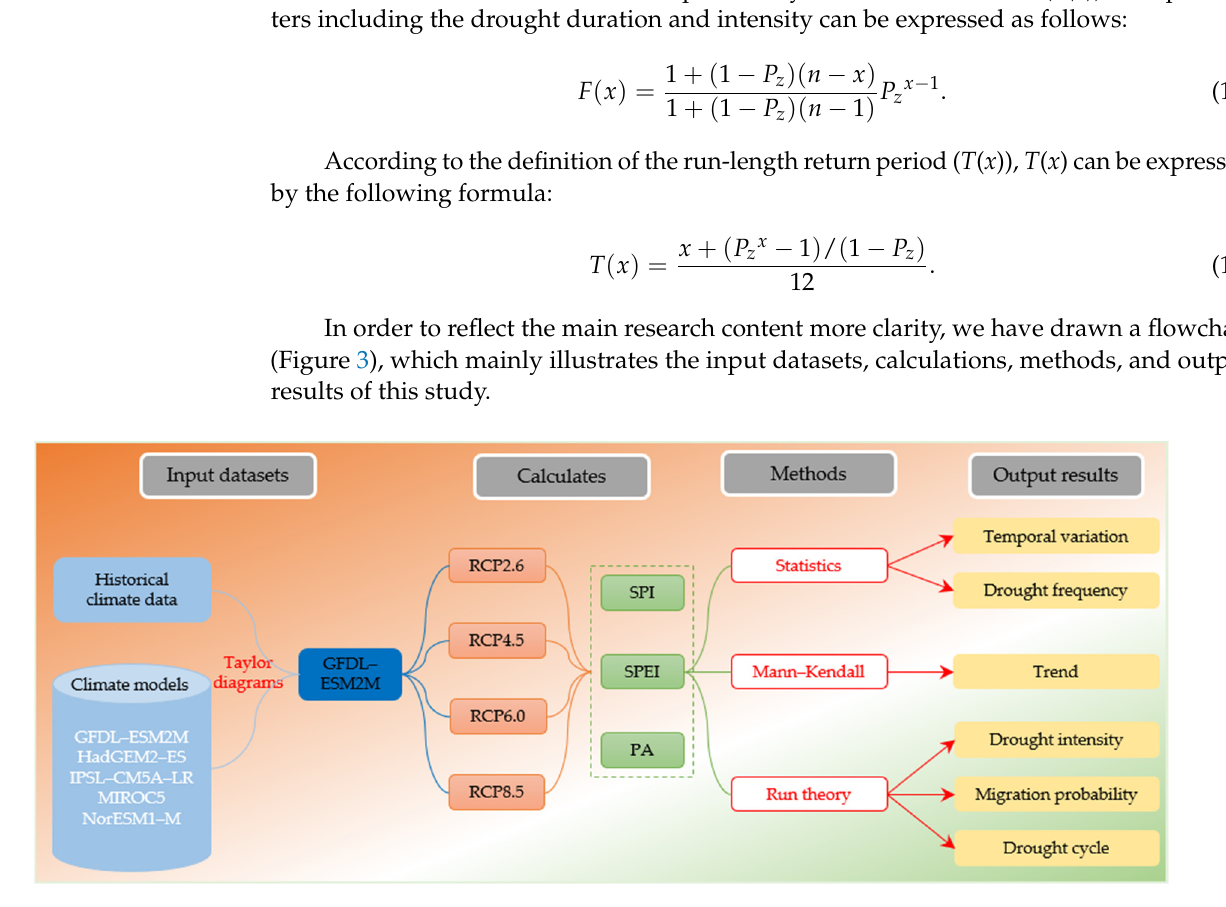
Figure 3. Flowchart including the main steps of input dataset, computation, method, and output result. The climate models are defined as follows: HadGEM2 ‒ ES-Hadley Centre global environment model version 2 ‒ Earth system configuration, IPSL ‒ CM5A ‒ LR-Institut Pierre-Simon Laplace to study natural climate variability and climate response to natural and anthropogenic forcings as part of the 5th phase of the coupled model intercomparison project, MIROC5-model of interdisciplinary research on climate version 5, and NorESM1 ‒ M-Norwegian Earth system model.